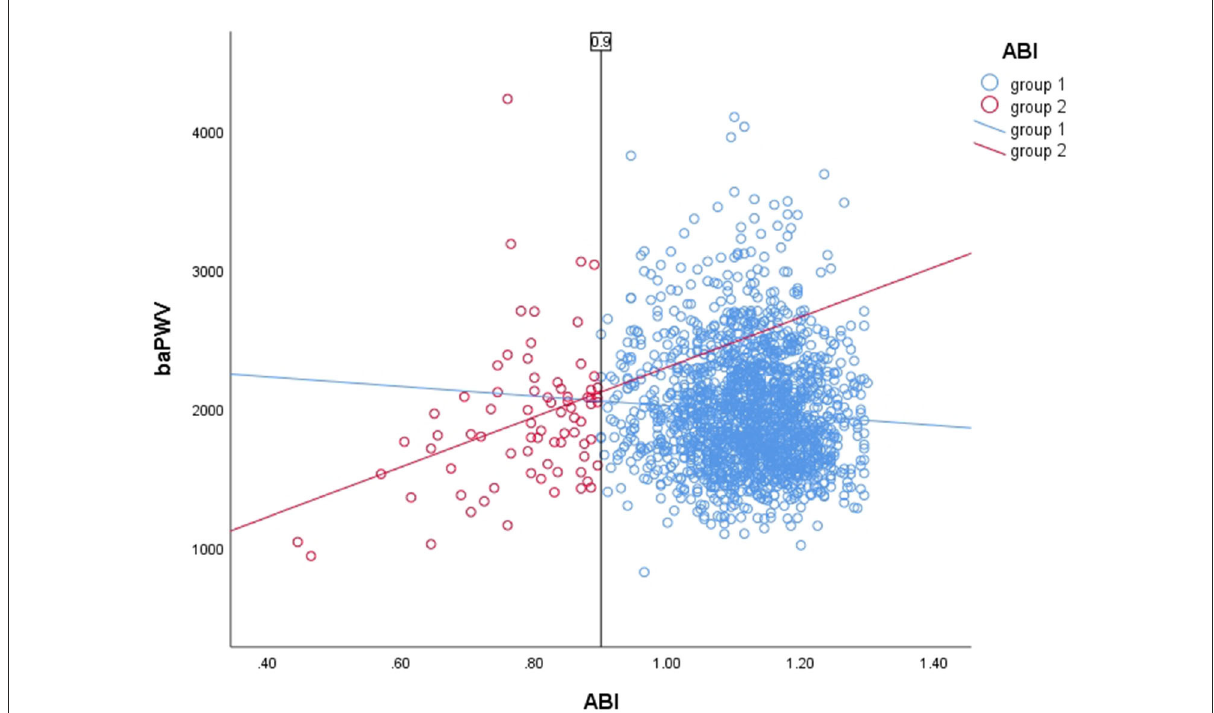
FIGURE3 Scatter plot of ABI and baPWV and their regression lines (group 1: R 2 = 0.004; group 2: R 2 = 0.113).